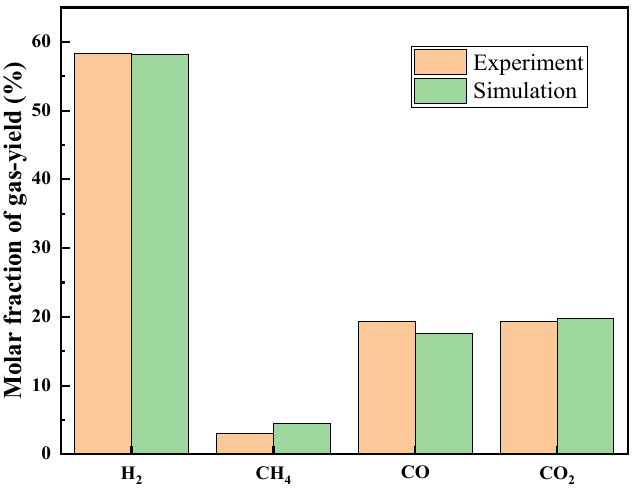
Figure 18. Comparison of mole fractions of components in experimental and simulated gas yield.